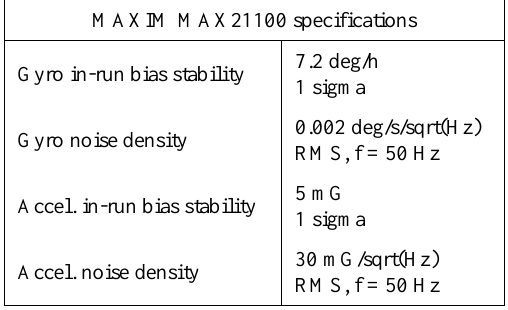
Table 4: Specifications for the MAXIM IMU